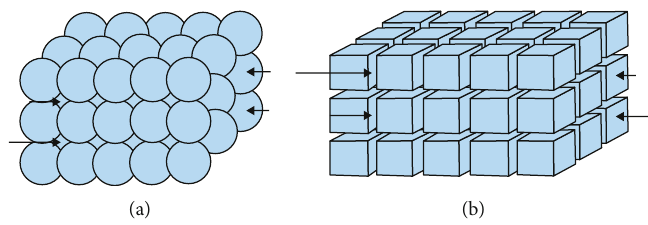
Figure 4: Unsteady-state (a) and pseudosteady-state (b) sorption/di ff